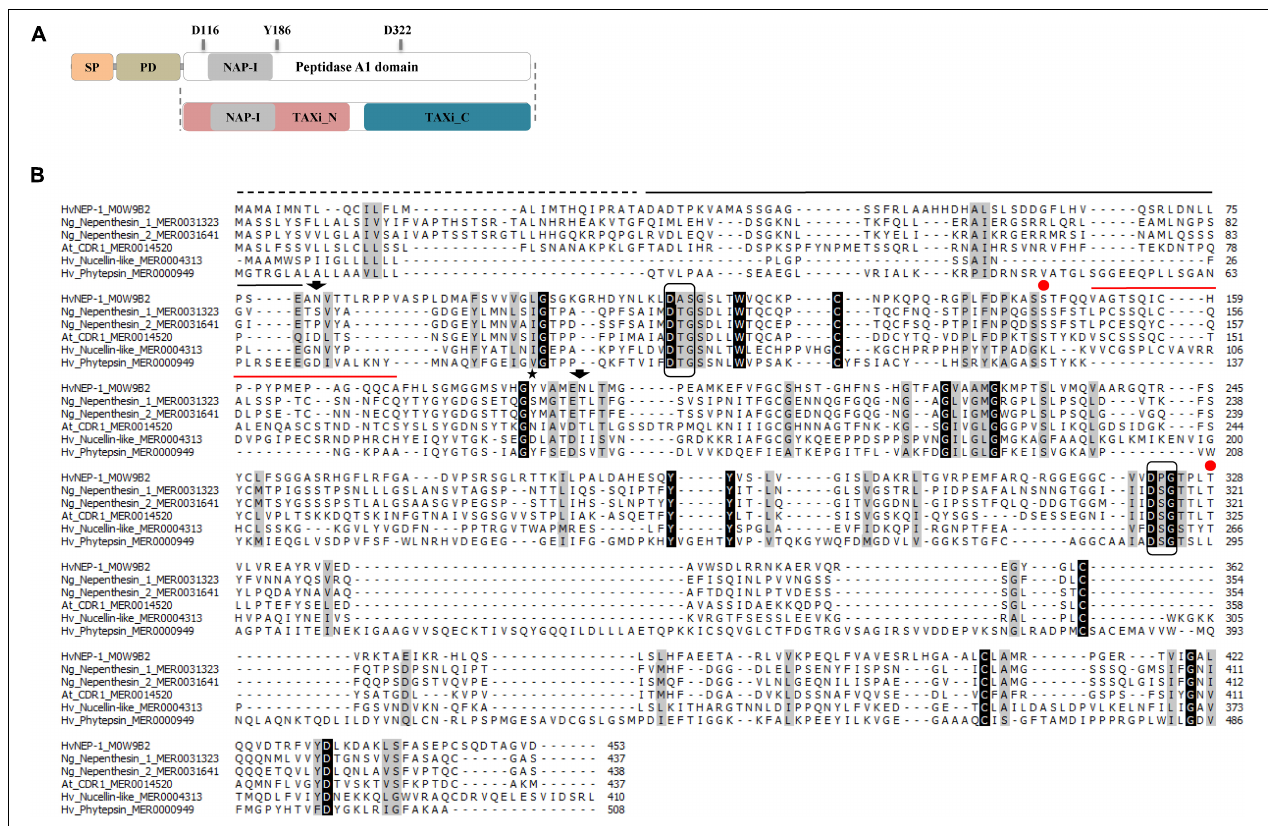
FIGURE 1 | Analysis of the nepenthesin 1 (HvNEP-1) sequence. (A) The primary structure organization of HvNEP-1. Primary structural domains are indicated as signal peptide (SP), prodomain (PD), and the peptidase A1 domain. The nepenthesin-type plant aspartic proteases (PAP) insertion (NAP-I), catalytic Asp residues (D116 and D322), and flap Tyr residue (Y186) are located inside the peptidase A1 domain. The Profile Hidden Markov Model (HMM) scan of HvNEP-1 locates the TAXi_N and TAXi_C domains. (B) Multiple sequence alignment of the HvNEP-1 and related PAPs. The PAP amino acid sequences retrieved from UniProt or MEROPS database are used for the alignment as follows: (1) Hordeum vulgare nepenthesin 1 (M0W9B2), (2) Nepenthes gracilis nepenthesin 1 (MER0031323), (3) N. gracilis nepenthesin 2 (MER0031641), (4) Arabidopsis thaliana CDR1 (MER0014520), (5) H. vulgare nucellin (MER0004313) and (6) H. vulgare phytepsins (MER0000949). SP (broken line), PD (black solid line), NAP-I (red solid line), catalytic triads (boxed), flap Tyr residue (Y186) (star), putative N-glycosylation sites (arrows), and Ser35 and Thr218 (red dots). Residues are shaded black or gray depending on the level of conservation among